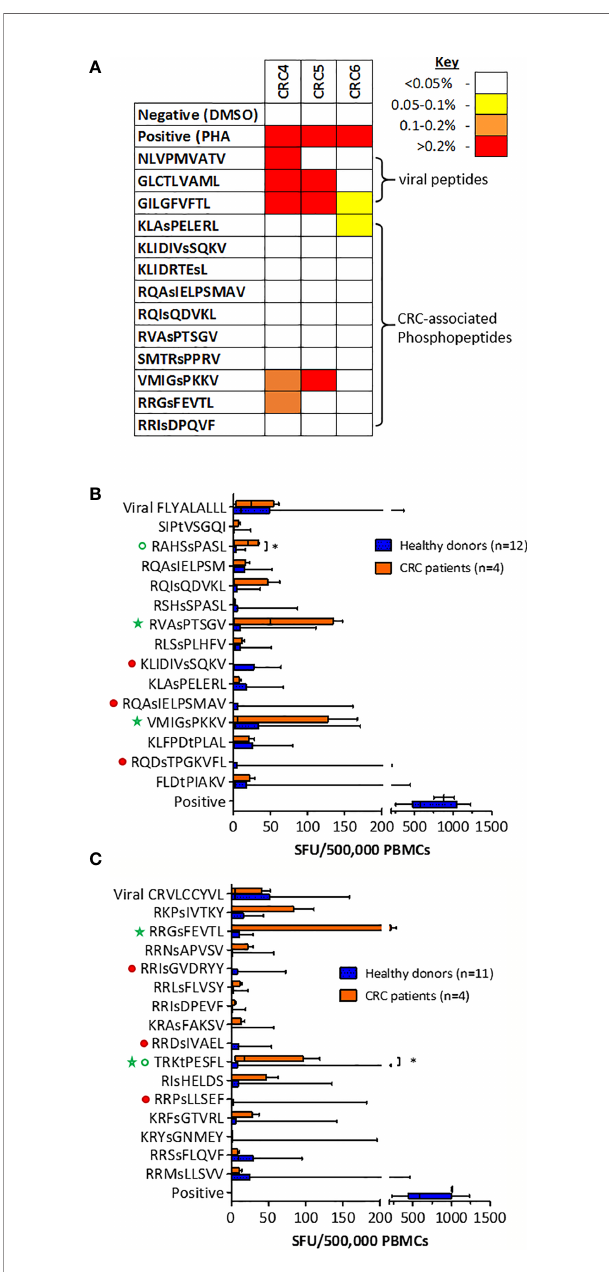
FIGURE 4 | T cellstargeting CRC phosphopeptides are found in a number of patients. (A) Summary of CRC TIL cytokine responses to common phosphopeptides (n=3). Box and whisker plots comparing HDand CRC patient PBMC IFNg production targeting (B) HLA-A*02-associatedphosphopeptides and (C) HLA-C*07-associatedphosphopeptides; median,interquartile range (box) andminima to maxima (whiskers) are shown.Responses that were absent (red circles) inCRC patients are highlighted. Green circles highlight the responses that were signi fi cantly higher in CRC patients than HD (Mann-Whitney U,* denotes p<0.05).Green starshighlight the phosphopeptides to which at least one patient had a high PBMC